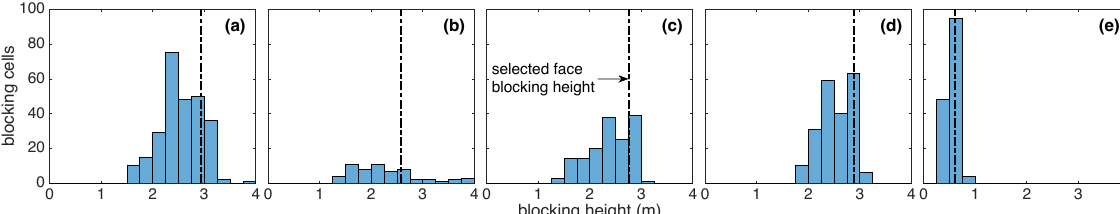
Figure 6. Histograms of the number of fine-grid blocking cells at different heights for five randomly selected coarse-grid cells in the data set. Dashed line represents the blocking height for the coarse-grid face selected as the 75th-percentile blocking height. Note that the maximum number of fine-grid cells in a single coarse-grid cell is 400.